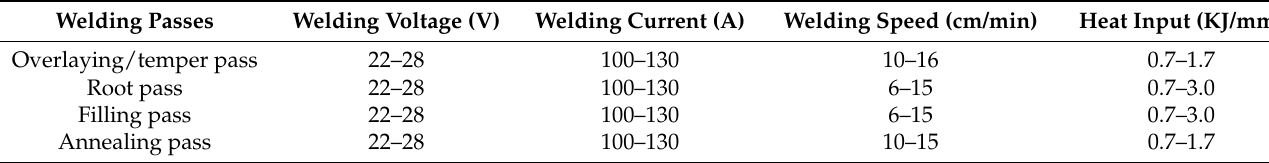
Figure 4. The von Mises stress contour: ( a ) 2D rotational simulation result, ( b ) 3D simulation result. The in-service sleeve repair welding model (Figure 1) was built according to the ac- tual weld joint. By considering the different requirements in the standards [16–18], the fillet weld size was found to affect structural safety significantly. The implementation of the new procure in the X80 pipeline by replacing the sleeve material with the higher level grade steel (X80) and reducing the welding passes is imperative in the future. Hence, the new procedure was designed to clarify the effects of the fillet weld size on the tempera- ture-microstructure-stress fields and the structural safety. 3.1. Finite Element Model The fillet weld sizes, ranging from 1.0 times to 2.6 times the wall thickness of X80 pipe, were considered in this investigation. Accordingly, the finite element models were built, as shown in Figure 5. The sequence and the number of the welding passes are marked in the picture. The 45° chamfers were all implemented in these cases. Finite ele- ment models have meshed with hexahedron cubic elements. To balance the accuracy and efficiency, coarser meshes were used in the regions away from the weld zone, and finer meshes were used near the weld zone, with the smallest element size of 0.5 mm × 0.7mm. The total element number was 10,566. Rigid restraints were applied at the ends of the X80 pipe, as shown in Figure 5. The pipe pressure, which was perpendicular to the pipe’s inner